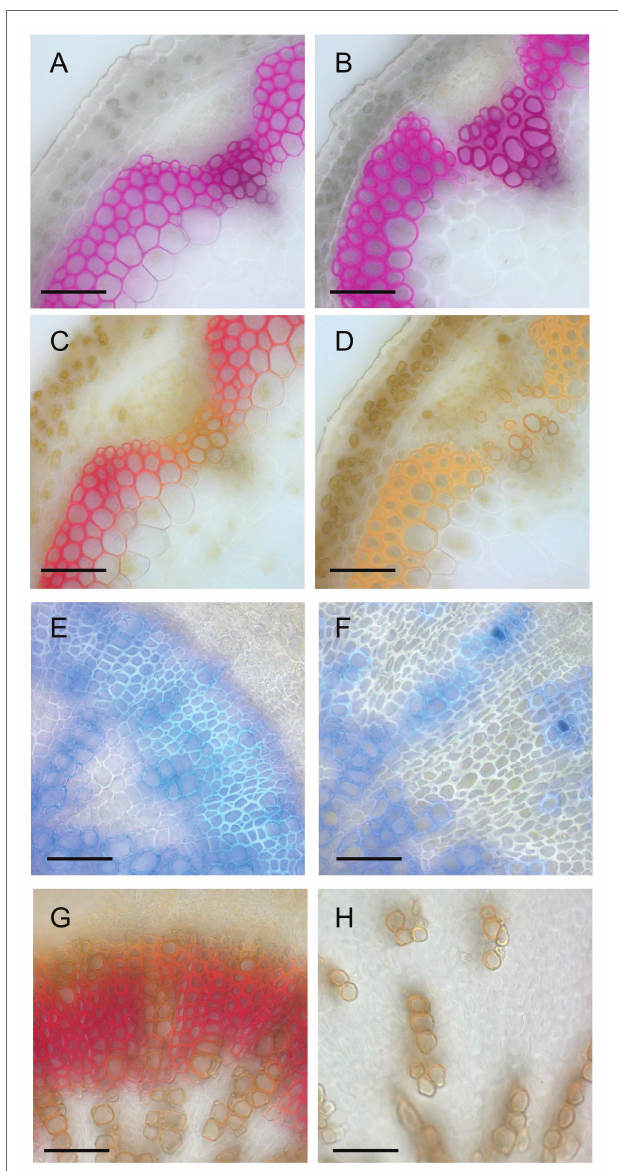
FIGURE 4 | Histological analysis of lignin deposition. (A,B) Phloroglucinol- stained sections of the inflorescence stems of wild-type (A) and a line (#23) of ERF041-VP16 (B) . (C,D) Mäule-stained sections of the inflorescence stems of wild-type (C) and #23 of ERF041-VP16 (D) . (E,F) Autofluorescence of lignin under UV illumination overlayed onto bright field image for wild-type (E) and #23 of ERF041-VP16 (F) hypocotyl sections. (G,H) Mäule-stained sections of the hypocotyls of wild-type (E) and #23 of ERF041-VP16 (F) . Bars, 50 μ